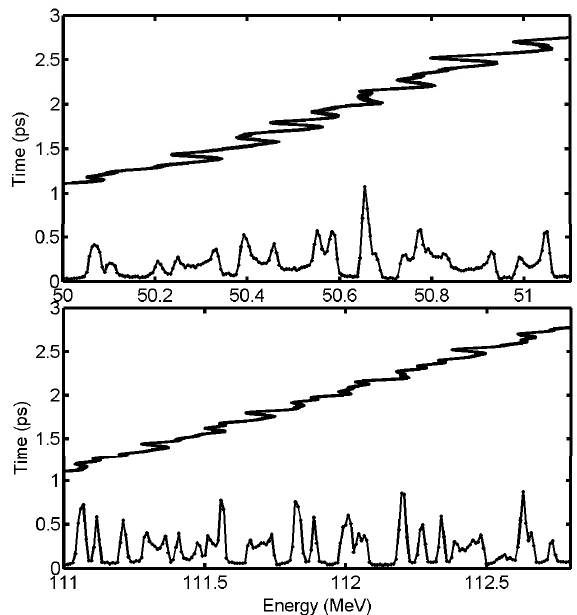
FIG. 7. Numerical simulation results. The final phase-space and energy spectra for 50 and 110 MeV beams assuming that the initial density modulation spectrum consists of six indi- vidual wavelengths (20, 30, 40, 50, 60, and 70 (cid:1) m ) with the same amount of density modulation ( (cid:9) 3%